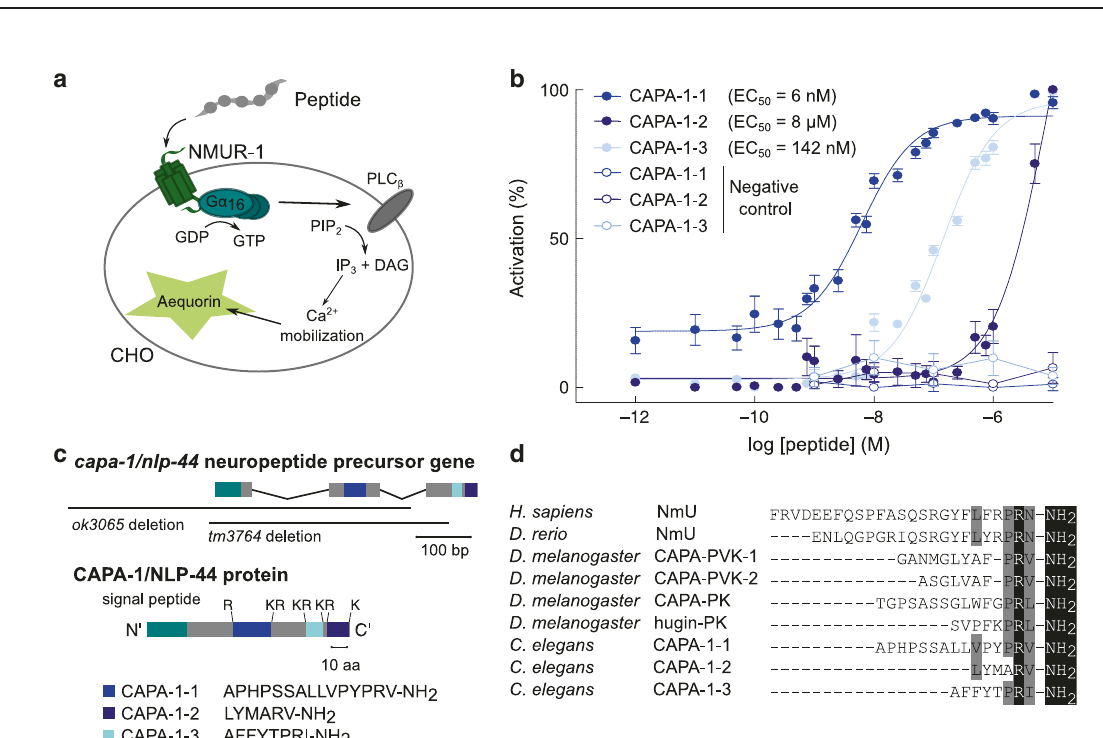
Fig. 4 CAPA-1 NMU-like neuropeptides activate NMUR-1 in a cellular assay for GPCR activation. a Luminescence-based calcium mobilization assay for measuring GPCR activation. NMUR-1 is expressed in CHO cells that stably co-express the promiscuous human G α 16 subunit, which couples receptor activation to calcium release from intracellular storage sites. Intracellular calcium levels are monitored using the calcium indicator aequorin. b Calcium responses of CHO cells expressing NMUR-1 are shown relative (%) to the highest value (100% activation) after normalization to the total calcium response. Cells transfected with an empty pcDNA3.1 vector are used as a control. Error bars show S.E.M. CAPA-1-1 n = 6; CAPA-1-2 n = 6; CAPA-1-3 n = 5 experimental repeats. c The capa-1/nlp-44 gene encodes a neuropeptide precursor that harbors three predicted peptide sequences (CAPA-1-1, -2, and -3), which are fl anked by mono- and dibasic cleaving sites. Black bars indicate the positions of deletions in capa-1/nlp-44 mutant alleles used in this study. d Sequence comparison of C. elegans CAPA-1 neuropeptides and NmU neuropeptides from H. sapiens , D. rerio , and D. melanogaster . Conserved C-terminal features are highlighted in black. Residues with similar physicochemical properties are colored (Fig. 4a). Only neuropeptides encoded by the capa-1/nlp-44 gene elicited a calcium response in NMUR-1-expressing cells. Cells transfected with an empty vector showed no response (Fig. 4b). family 7,25 . It encodes three predicted peptides with a C-terminal YXPR(I/V)-NH 2 motif, resembling the PRX-NH 2 motifs of Drosophila and mammalian NMU peptides 42 (Fig. 4c, d). In Drosophila NMU-like peptides are encoded by the capability and hugin genes. Due to the sequence similarity of nlp-44 with the insect capability gene , C. elegans nlp-44 has been named capa-1 25 .